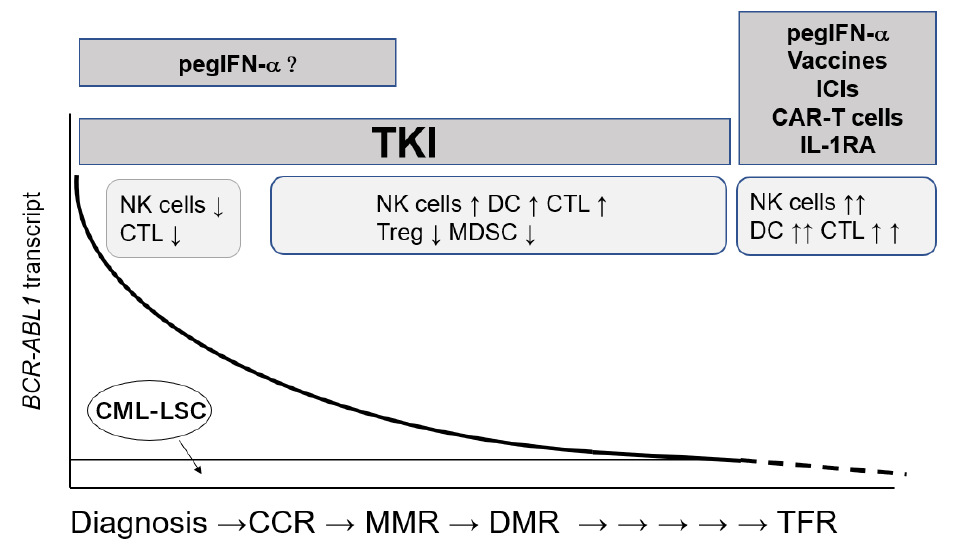
Figure 3. Clinical course of CML-CP patients and immunotherapies combined with TKI therapy to achieve TFR.